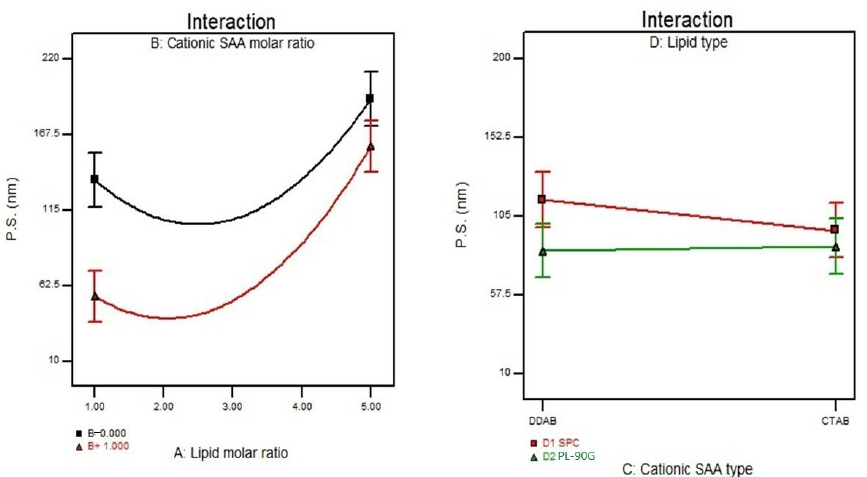
Figure 2. The effect of lipid molar ratio (X 1 ), cationic surfactant molar ratio (X 2 ), cationic surfactant type (X 3 ), and lipid type (X 4 ) on P.S. Abbreviation: P.S., particle size.